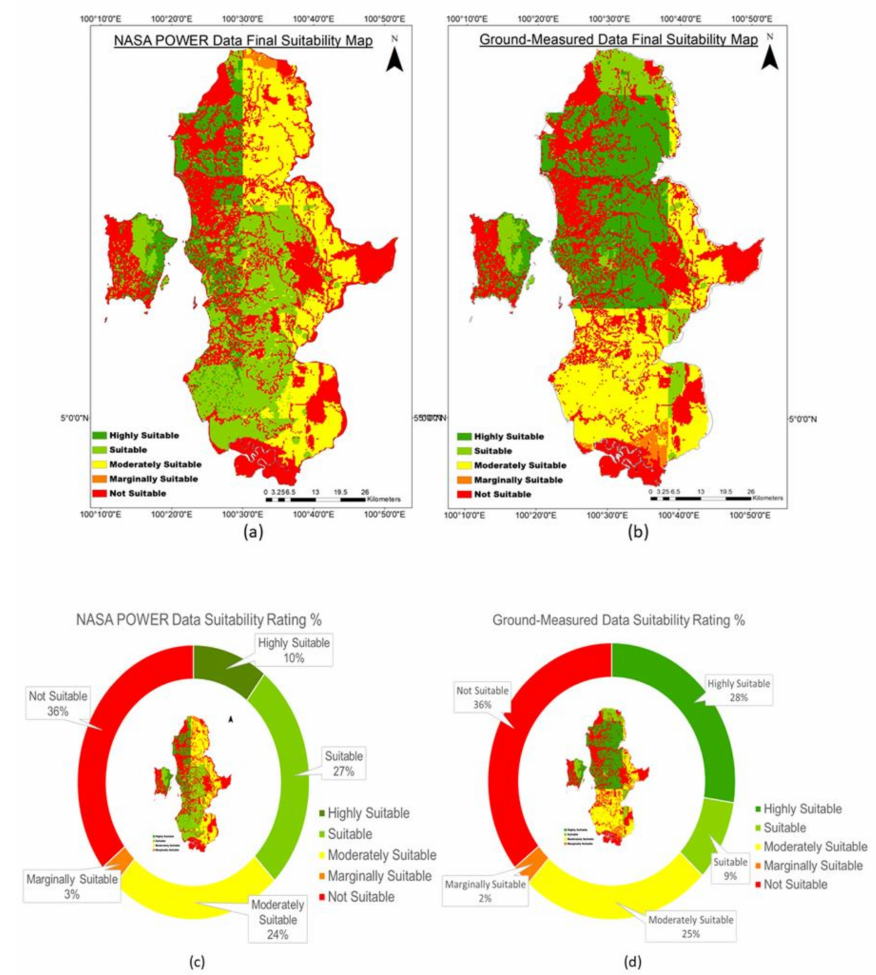
Figure 6. ( a ) The suitability map generated using the NASA POWER data, ( b ) the suitability map generated using ground-measured data, ( c ) the percentage of the suitability rating for the NASA POWER data map, ( d ) the percentage of the suitability rating for the ground-measured data